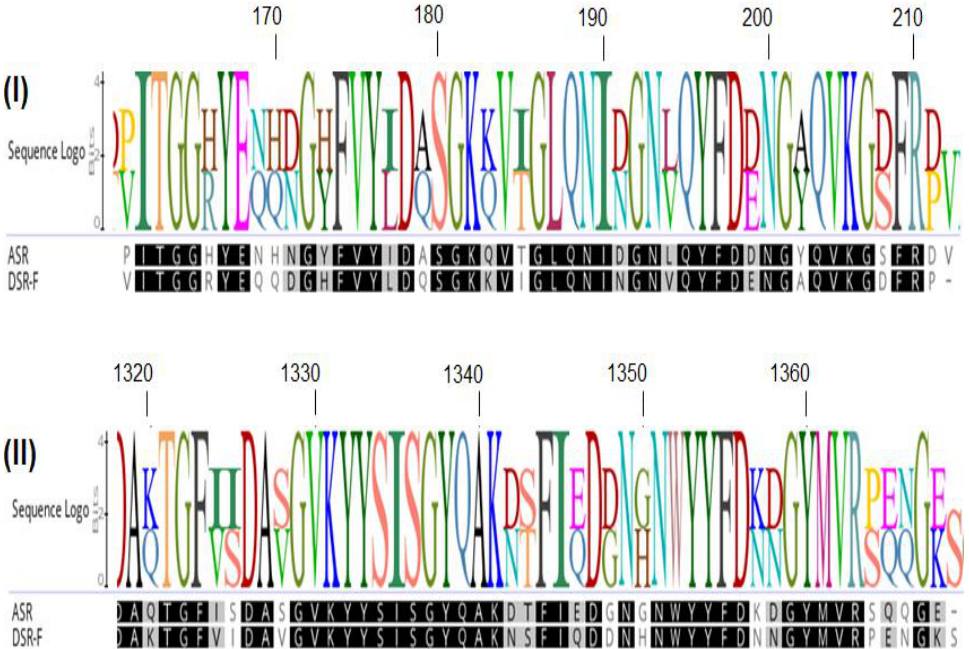
Figure 4. Domain V sugar-binding pockets sequence comparison. Alignment of the residues corre- sponding to two sugar-binding pockets V-A ( I ) and V-C ( II ) of alternansucrase ASR from L. citreum NRRL B-1355 (PDB entry 6SYQ) with the equivalent residues in dextransucrase DSR-F. In the acceptor reaction (maltose as the acceptor molecule) performed with DSR-F- ∆ SP- ∆ GBD-CBM2a, a series of analog isomaltodextrins very similar to the ones produced by the recombinant dextransucrase DSR-F-ΔSP-ΔGBD from L. citreum B/110-1-2 (Figure 3II) were synthesized. The isomalto-oligosaccharide (IMO) products with 7 and 8 glucose units showed two extra peaks (Figure 3II, arrows), indicating that they were decorated with at least one branched α (1–4) glucose unit. These IMO products correspond to previously characterized oligodextrans [20]. From these observations, it seems that the cellulose-binding domain of DSR-F- ∆ SP- ∆ GBD-CBM2a does not affect the synthesis of HMM and LMM glucans from sucrose and IMO products from sucrose/maltose, respectively. 2.4. Action of DSR-F-ΔSP-ΔGBD-CBM2a from Sucrose and Linear Oligodextrans (1500 and